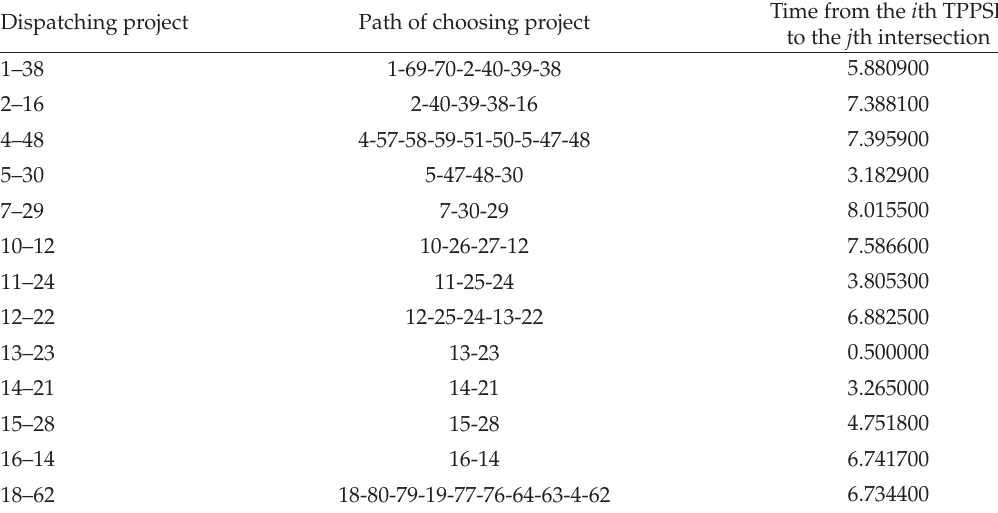
Table 2: The optimal dispatch project of TPPSP with T pq (cid:8)